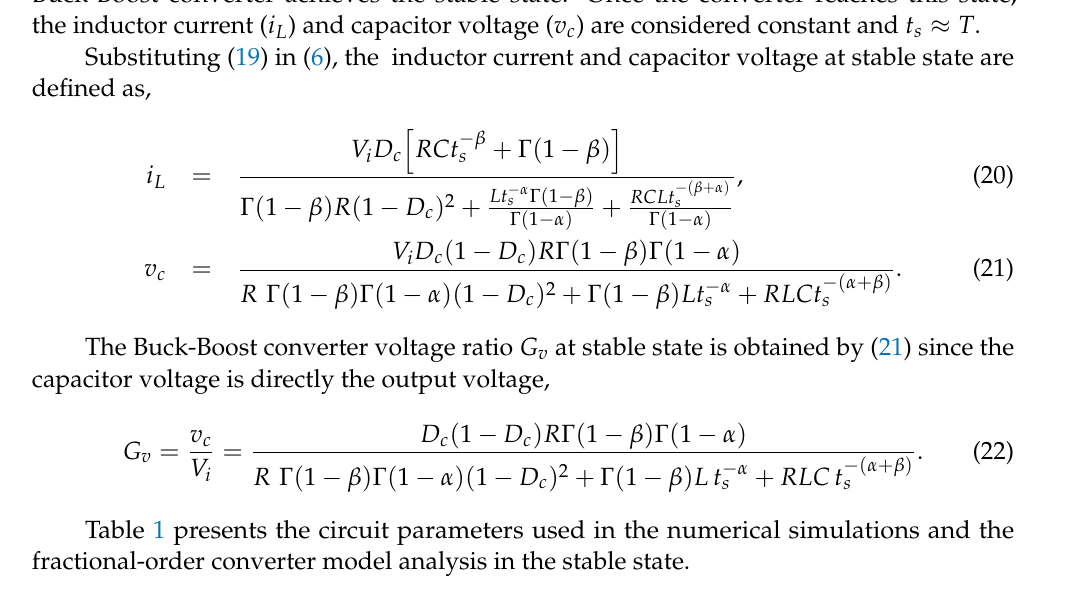
Table 1. Parameters used for the simulations to obtain the Buck-Boost converter fractional model response in the stable state.